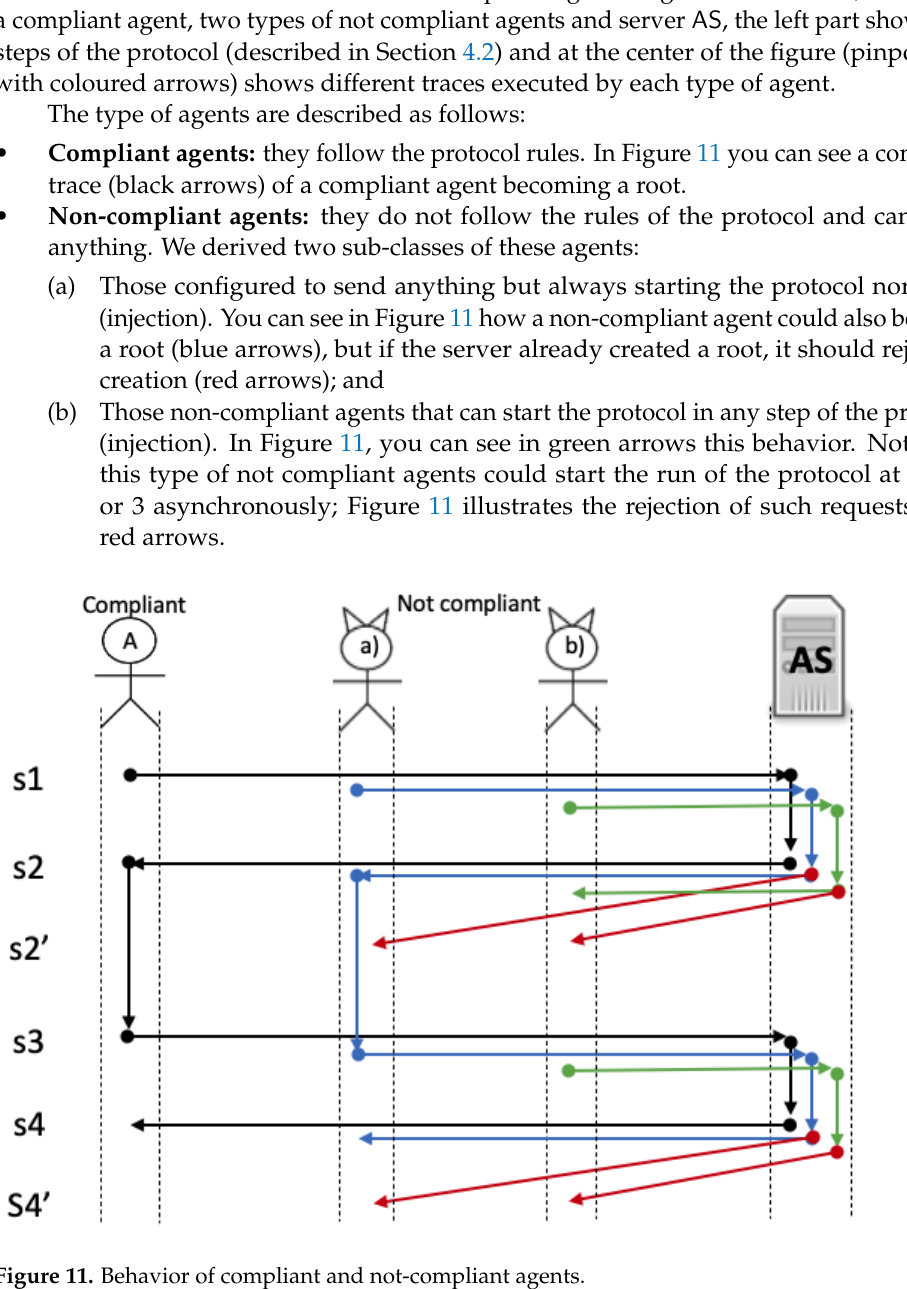
Figure 11. Behavior of compliant and not-compliant